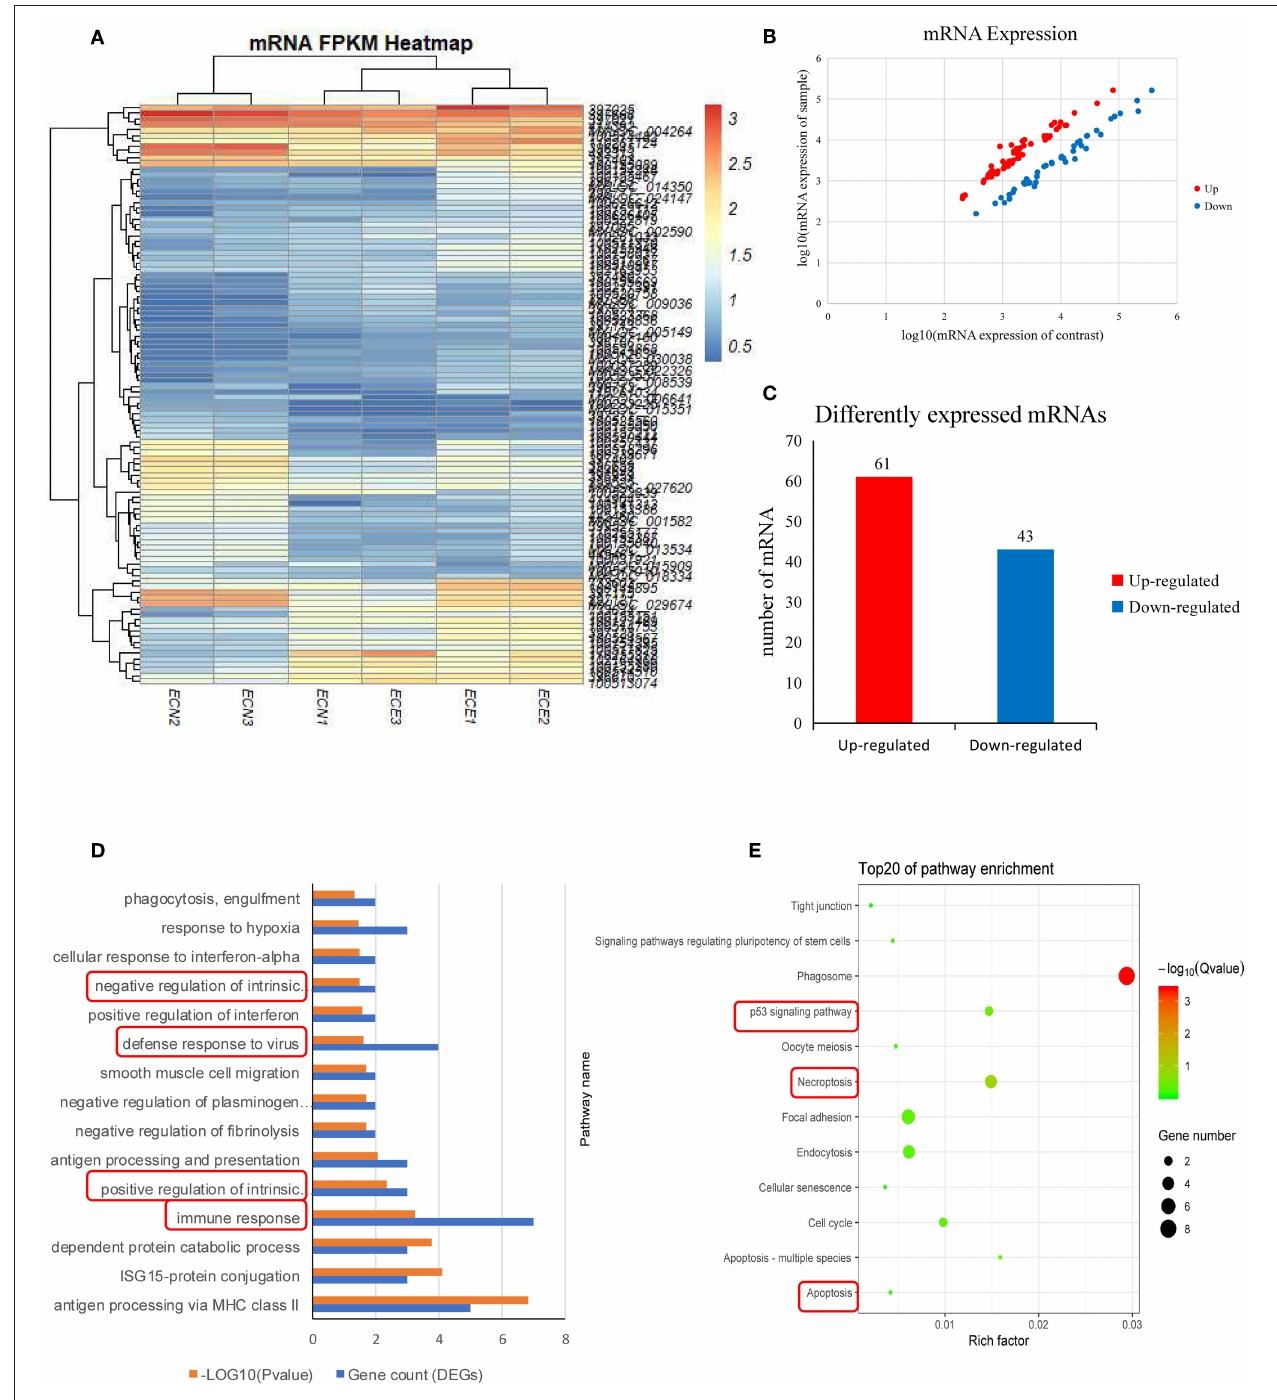
FIGURE 3 | Screening and enrichment analysis of differently expressed genes (DEGs) in PRRSV-infected PECs compared with non-infected PECs. (A) Hierarchical clustering analysis (heatmap) for DEGs using Pearson’s correlation. (B) DEG expression level analysis by scatter plot. The red spots in this figure represent up-regulated mRNAs, the blue spots represent down-regulated mRNAs. (C) Detailed analysis on the up-/down-regulated DEGs. Sixty-one up-regulated and 43 down-regulated DEGs were shown. (D) The first 20 GO terms analysis ( P < 0.005) of DEGs in biological process. The red textbox in the figure indicate the main processes that related into cells immunology. A –log 10 ( P- value) > 2 was considered as significantly different. (E) KEGG signal pathway enrichment analysis of DEGs ( P < 0.01). The pathways labeled with red textbox were important pathways that are related to cells apoptosis.